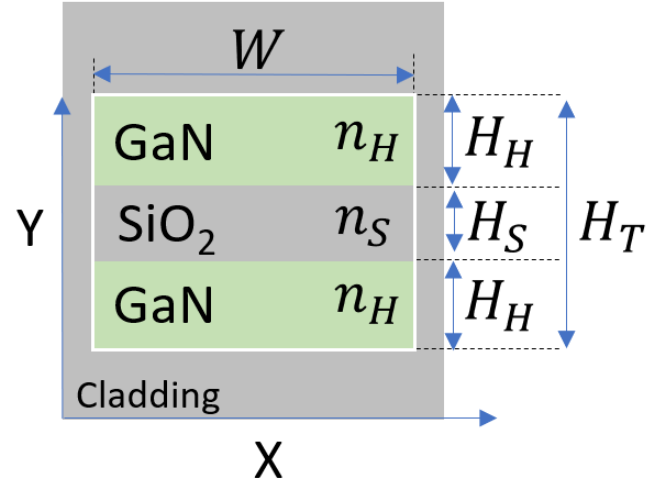
Figure 1. Schematic sketch of slot waveguide structure at the x–y plane.